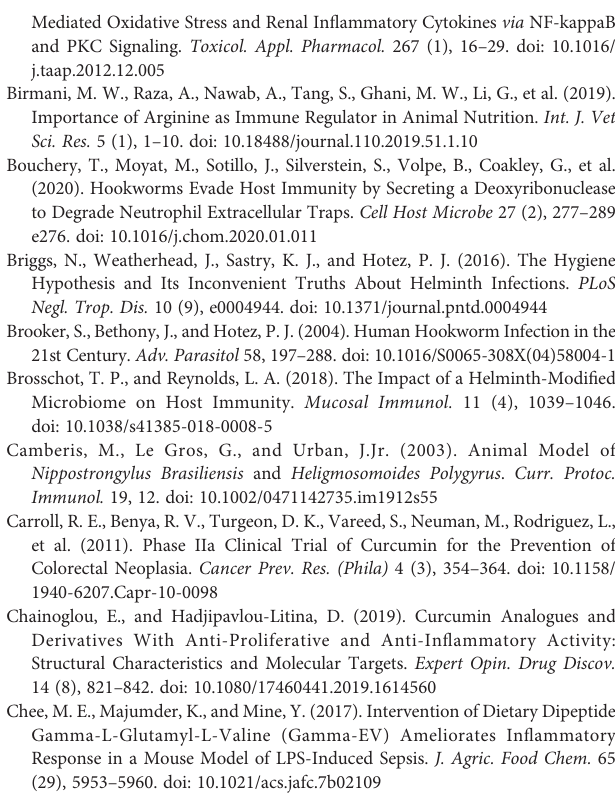
Supplementary Figure 1 | Evaluation of the quality of the experiment. The total ion chromatography (TIC) of the QC sample in modes of positive ion (A) and negative ion (B) . Retention time is denoted by x -axis bars, while total ionic strength is represented by y -axis bars. PCA score plots of all experimental samples in the modes of positive ion (C) and negative ion (D)